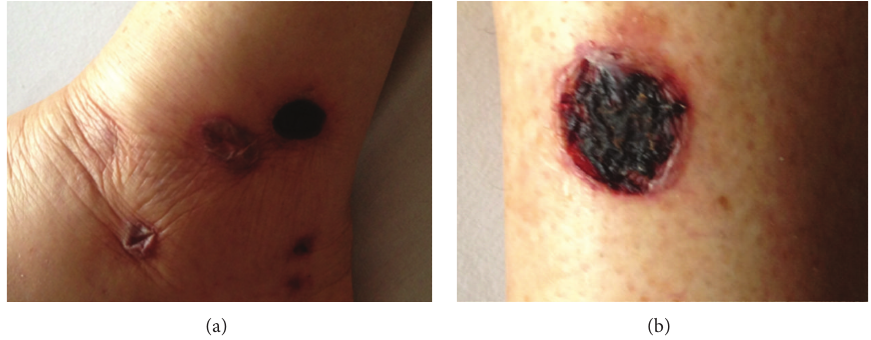
Figure 1: Vasculitic lesions with necrotic center in lower limbs in a patient with granulomatosis with polyangiitis.